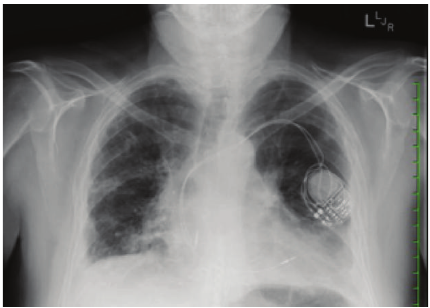
Figure1:Chestradiography(CXR)showeddiffusepatchyinfiltrates and small bilateral pleural effusions.